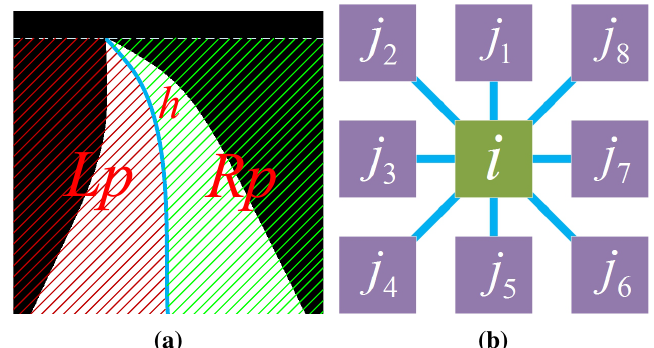
Figure 14. Illustration of the road shape prior: ( a ) a road segment with the middle line h ; Lp denotes the left part of h ; Rp denotes the right part of h ; ( b ) a standard eight-neighborhood system with a center pixel i and its neighbors j